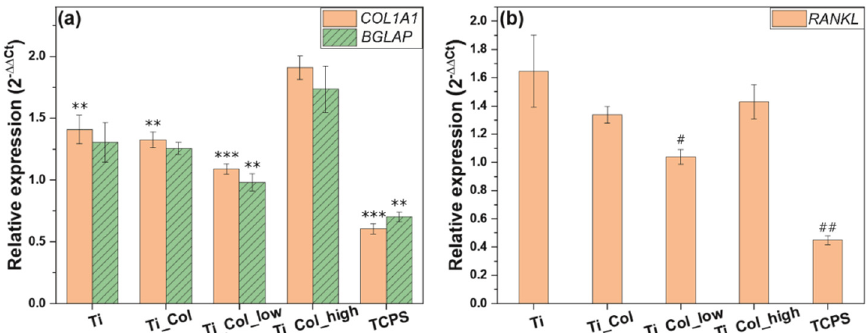
Figure 4. Relative expression of ( a ) COL1A1 and BGLAP genes and ( b ) RANKL gene in osteoblast-like cells. Ti: titanium alloy Ti6Al4V; Ti_Col: collagen-coated Ti; Ti_Col_low: collagen and low PG concentration-coated Ti; Ti_Col_high: collagen and high PG concentration-coated Ti. Error bars represent the standard error of the mean. One-way ANOVA and Bonferroni corrections for multiple comparisons. A significant level of 0.05 was used throughout the study. * Significant di ff erence between Ti_Col_high and other tested samples / Ti and Tissue Culture Polystyrene (TCPS) controls. ** p < 0.01; *** p < 0.001. # Significant di ff erence between Ti control and tested samples / TCPS control. # p < 0.5, ## p <